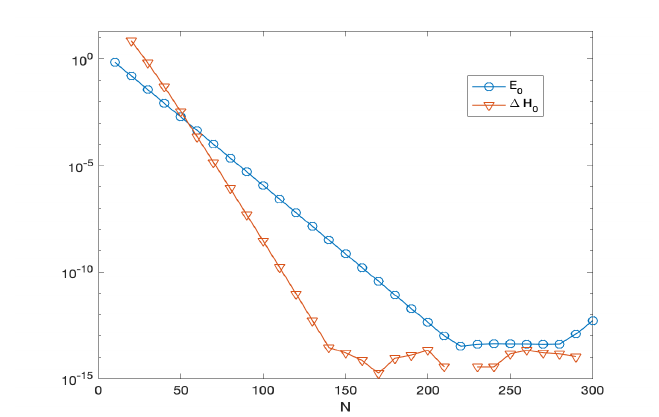
Figure 1. Sine-Gordon Equation (92); upper plot: solution (93); lower plot: E 0 (see (89)) and ∆ H 0 (see (91)) versus N